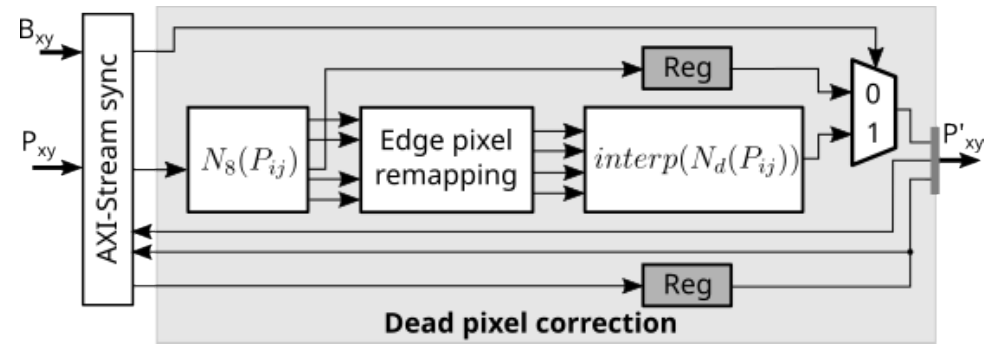
Figure 5. Defective pixel correction